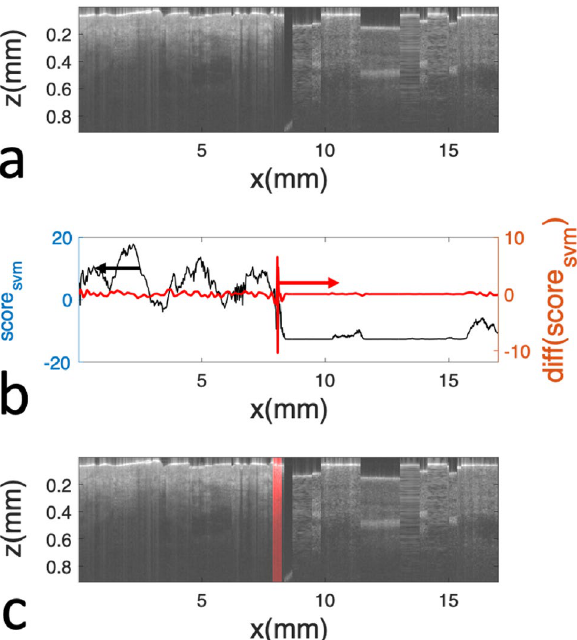
Figure 6. ( a ) OCT image obtained by scanning the fiber-optic probe across the junction between the skin and the nail plate from a healthy subject; ( b ) spatially resolved SVM prediction score (black curve), and first order difference of filtered prediction score (red curve); ( c ) boundary between skin and anormal tissue (red shade) identified through one-class SVM